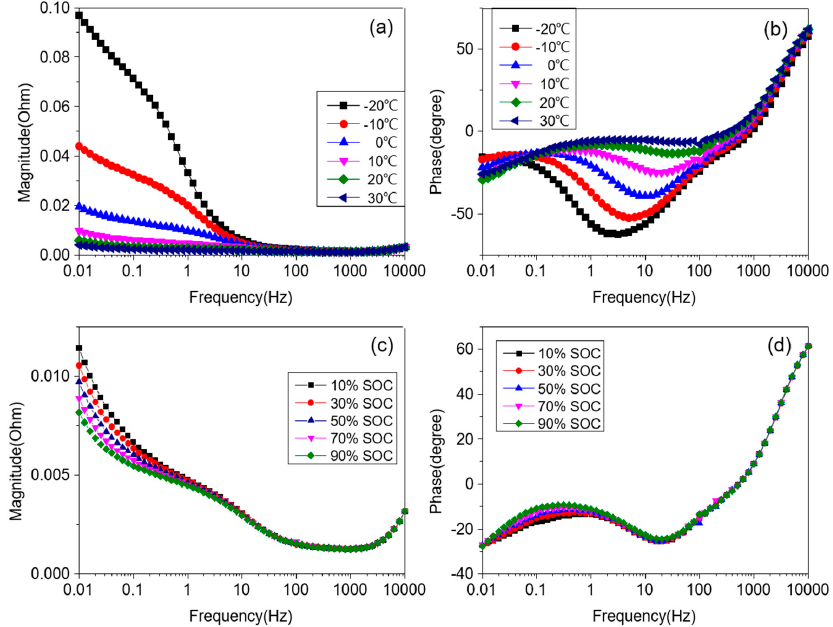
Figure 11. EIS of the battery in Bode plots with uniform temperature: ( a , b ) impedance magnitude and phase of battery at 50% SOC, different temperatures; ( c , d ) impedance magnitude and phase of battery at 10 °C, different SOCs. Energies 2018 , 11 , 220